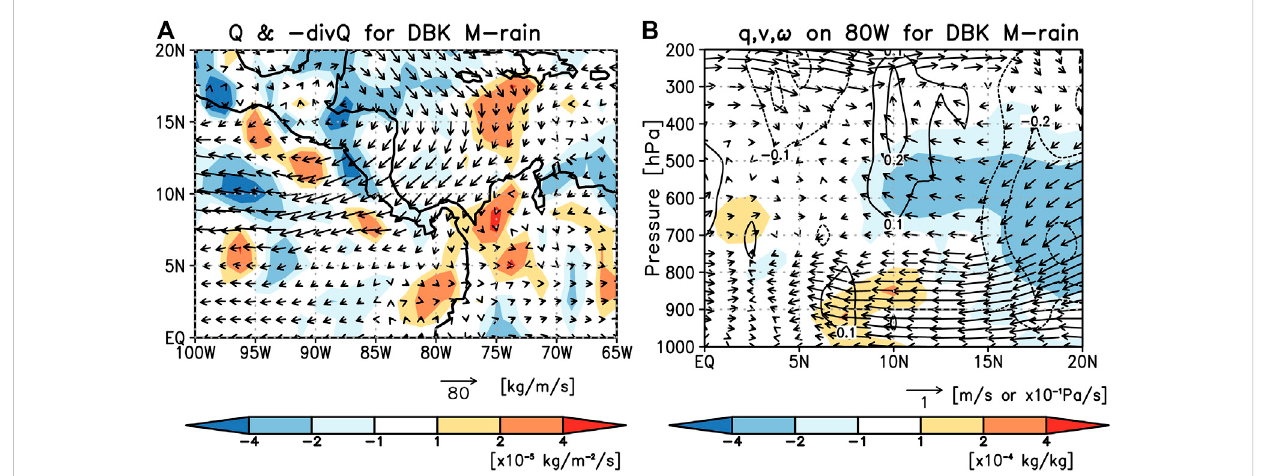
FIGURE 10 Composited vertically integrated moisture fl uxes (vectors) and their convergence (shade) at 1 LT on days when the morning rain > 1 mm were observedatDBKinAugustfortheperiodfrom2000to2016 (A) .Averticalcrosssectionofthemeridionalmotion,verticalmotion,andspeci fi chumidityat 80 ° W (B) . The composite was conducted with JRA-55 reanalysis, and anomalies from the normal state are shown.